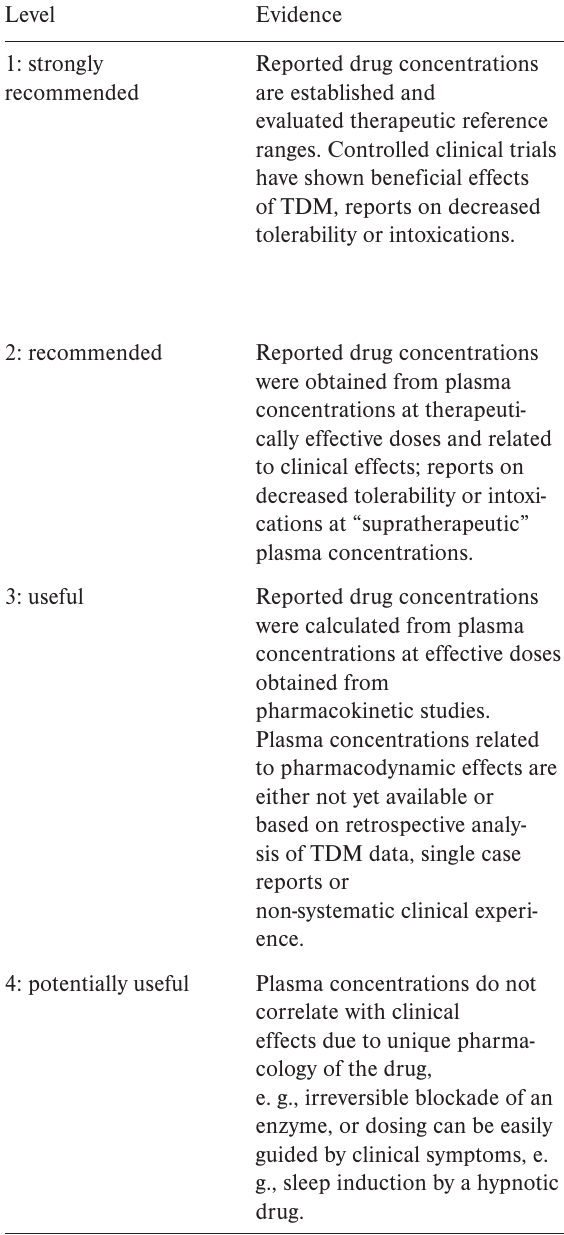
Table 4. Levels of recommendation for TDM in psychiatry by Arbeitsgemeinschaft für Neuropsychopharmakologie und Pharmakopsychiatrie 9 . Level Evidence Recommendation Clinical